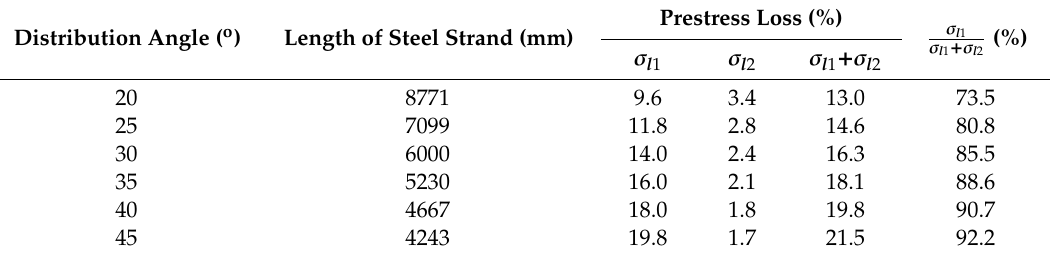
Table 8. Theoretical prestress loss of steel strands given the slab width of 3.0 m.